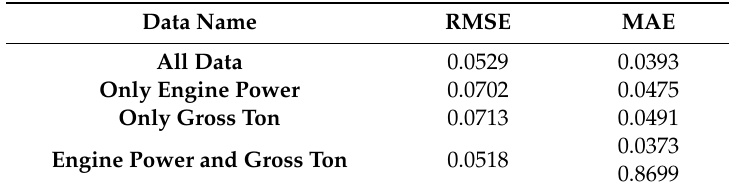
Table 6. RMSE and MAE values for ANN